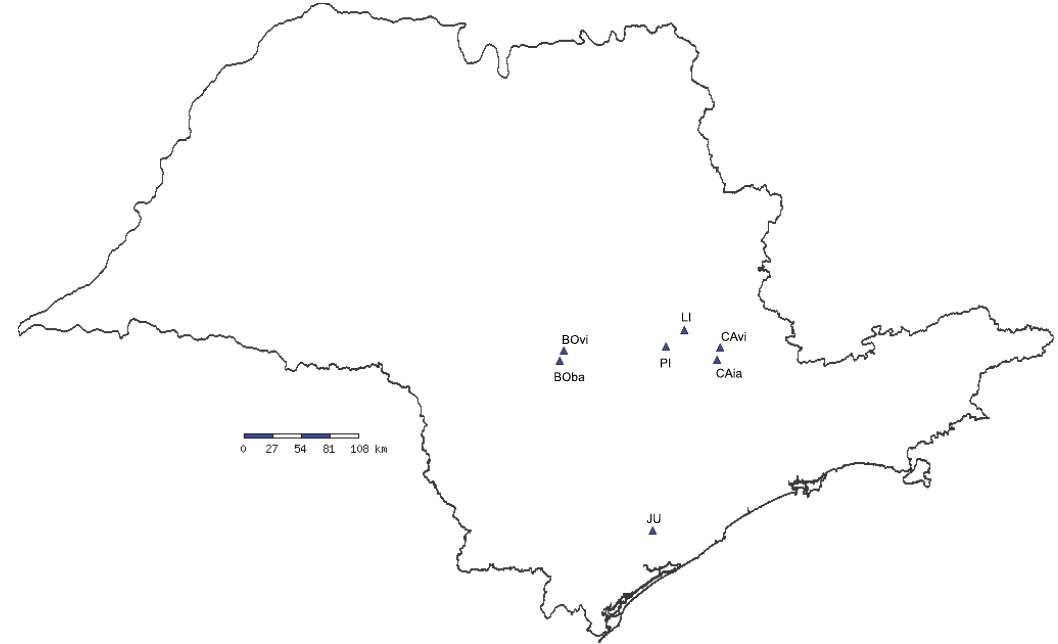
Figure 1. Map of populations included in this study from Sa˜o Paulo State, SE Brazil.